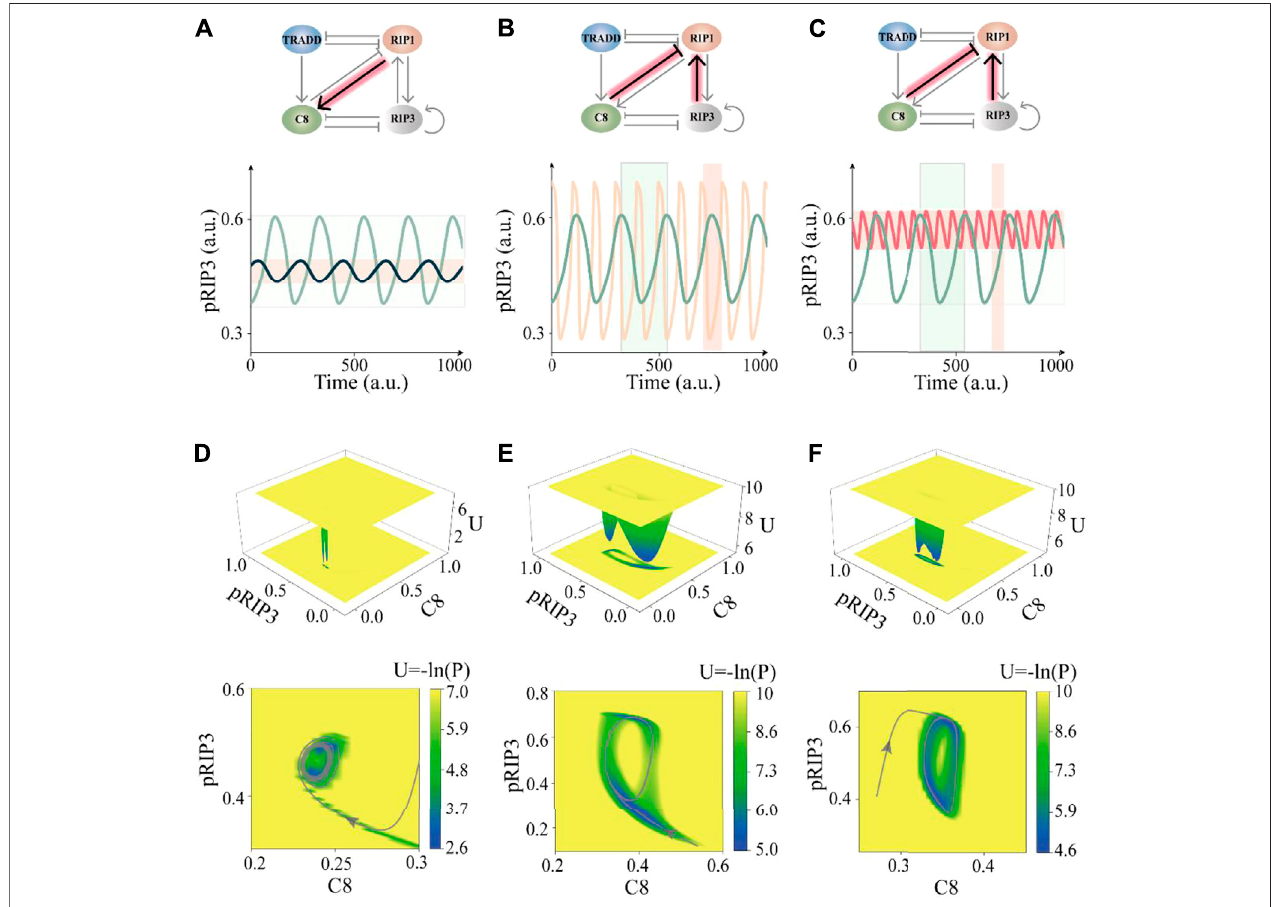
FIGURE 7 | Parameters tuning in loop of the unidirectional bias leads to oscillation behavior changes. (A) The values of (k6, j6) from (0.24, 3.2) to (0.38, 3.55) switches thesystembehaviorfrom HSoscillation (OSC (cid:1) 0.46/period (cid:1) 209.5) toLS oscillation (OSC (cid:1) 0.12/period (cid:1) 201.2). (B) The valuesof(k4,j3) from (0.2,78.6) to (2.3, 0.005) switches the system behavior from HS oscillation (OSC (cid:1) 0.46/period (cid:1) 209.5) to HF oscillation (OSC (cid:1) 0.83/period (cid:1) 99.0). (C) The values of (k4, j3) from (0.2, 78.6) to (2.19, 0.22) switches the system behavior from HS oscillation (OSC (cid:1) 0.46/period (cid:1) 209.5) to LF oscillation (OSC (cid:1) 0.20/period (cid:1) 66.0). (D – F) Landscape of the system with switching oscillation behavior by tuning parameters. (D) The LS oscillation corresponds to sub- fi gure (A) . (E) The HF oscillation corresponds to sub- fi gure (B) . (F) The LF oscillation corresponds to sub- fi gure (C) . The gray curve in the lower panel represents an evolution trajectory in the phase